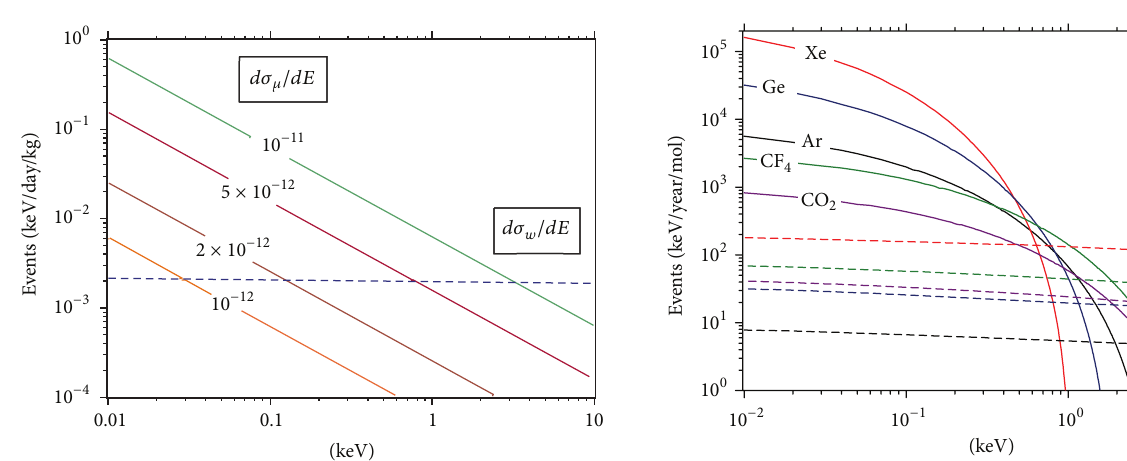
Figure 1: The count rate for antineutrino-electron elastic scattering as a function of energy in keV for different values of magnetic moment. By dashed line is indicated the count rate by standard elec- troweak model. The flux of antineutrinos is taken here 10 13 ] /cm 2 /s.